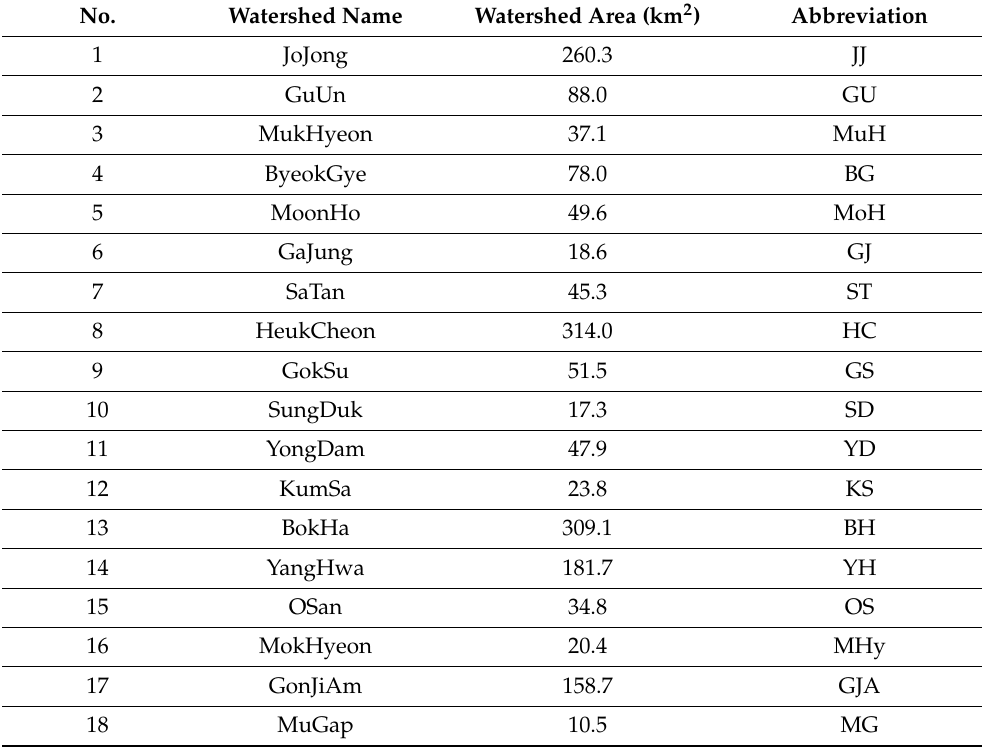
Table 1. Summary of study